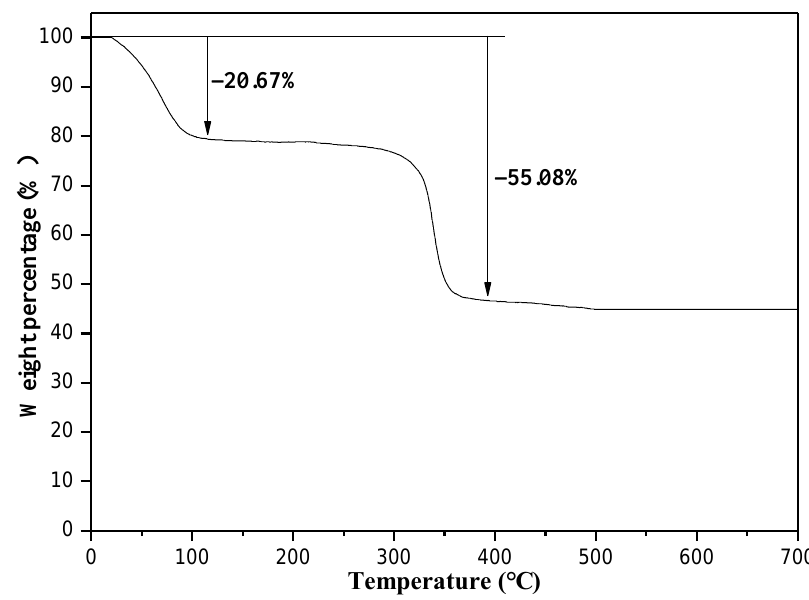
Figure 3. TG curves of Co-ZIF catalyst.